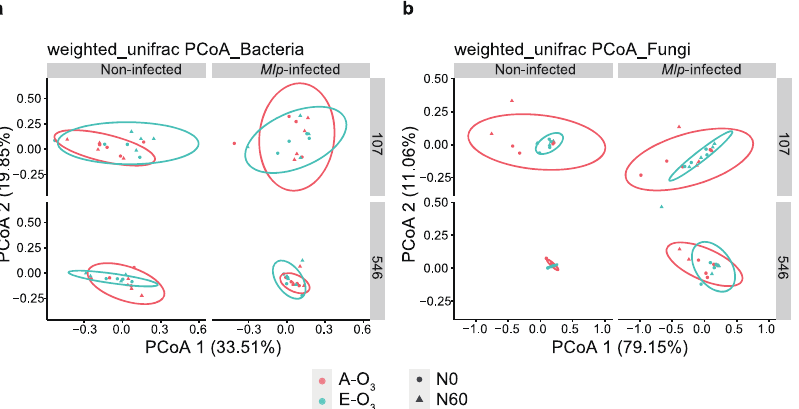
Figure 4. PCoA of bacterial and fungal communities using the weighted_unifrac distance for bacteria ( a ) and unweighted unifrac distance for fungi ( b ). Samples are sorted for ozone concentration (A ‐ O 3 vs. E ‐ O 3 ) and nitrogen treatment (N0 vs. N60). Table 1. The effects of polar clone, N addition, elevated O 3 concentration and Melampsora larici ‐ populina ( Mlp ) infection on the phyllosphere bacterial and fungal communities based on PER ‐ MANOVA analysis.